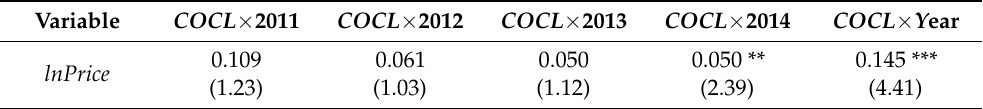
Table 9. Placebo test results: randomly selected years between 2011 and 2014.